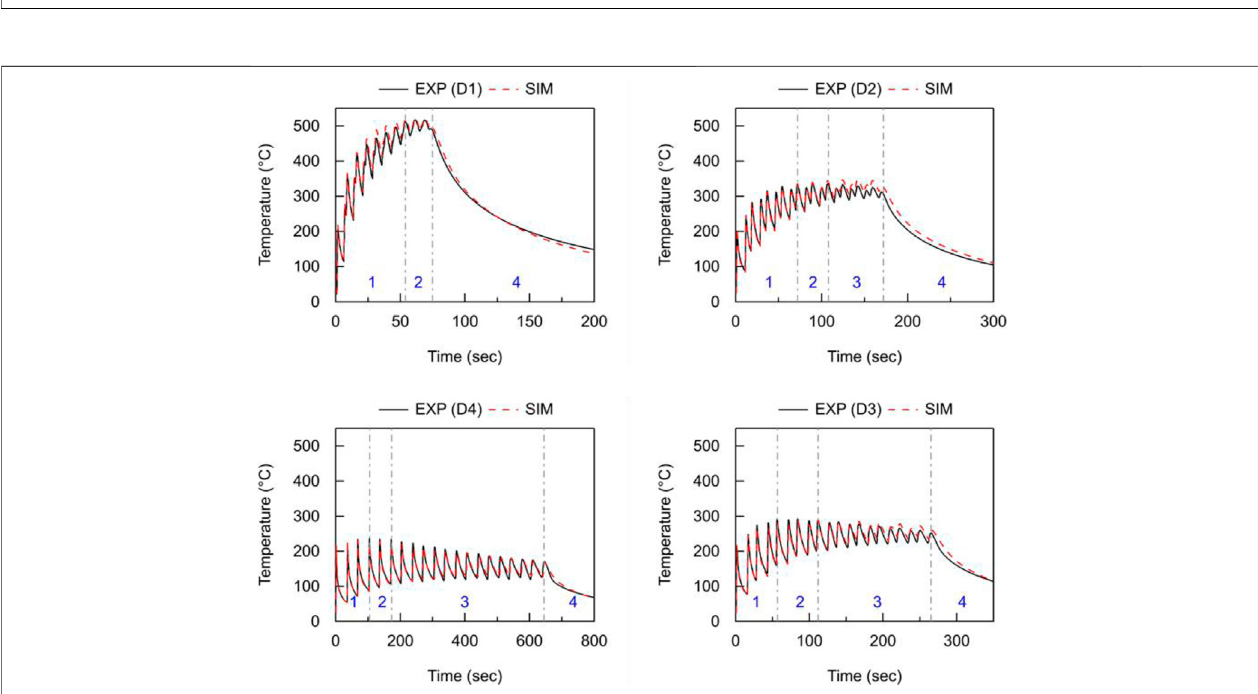
FIGURE 5 | Temperature distribution during deposition of 12th layer utilising Quiet/Active material activation.